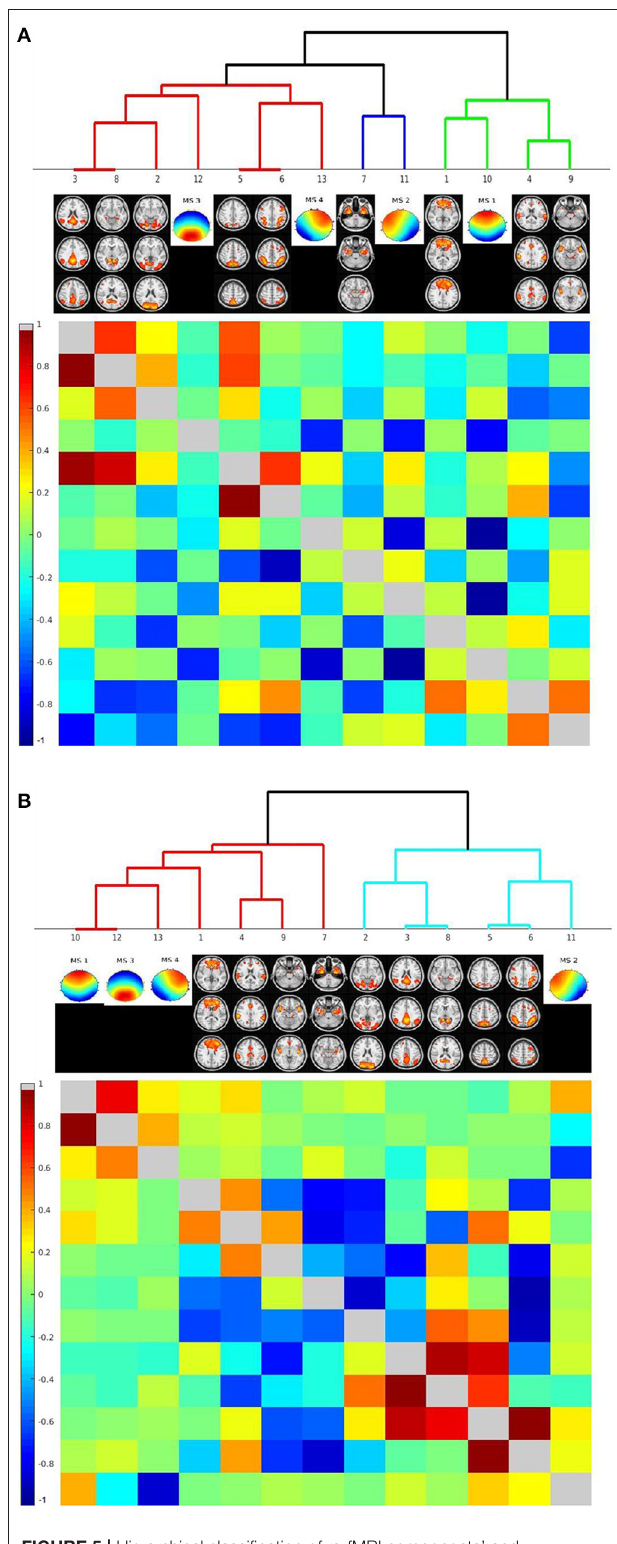
FIGURE 5 | Hierarchical classification of rs-fMRI components’ and microstates’ time courses based on their cross-correlation across individuals.